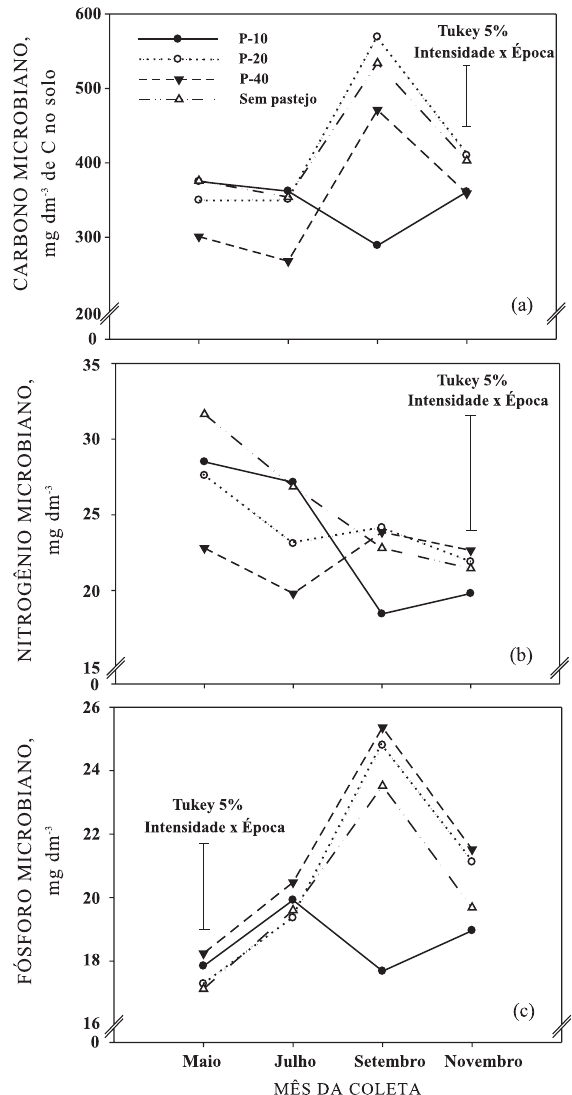
Figura 2. Carbono (a), nitrogênio (b) e fósforo (c) na biomassa microbiana no ciclo de pastejo, na ca- mada de 0 a 10 cm, de um Latossolo Vermelho em função de intensidades de pastejo em siste- ma de integração lavoura-pecuária sob plantio direto. P-10, P-20 e P-40 representam as alturas de pastejo de 10, 20 e 40 cm,